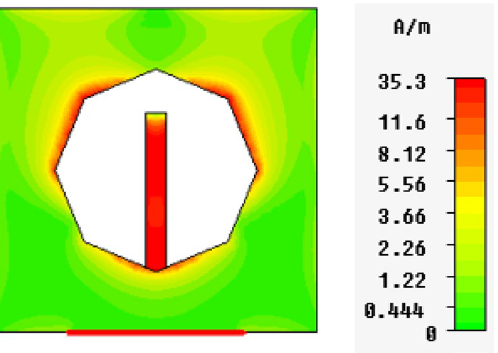
Figure 15. Magnetic intensity distributions for Antenna3 at the fundamental resonance of 5.2 GHz.